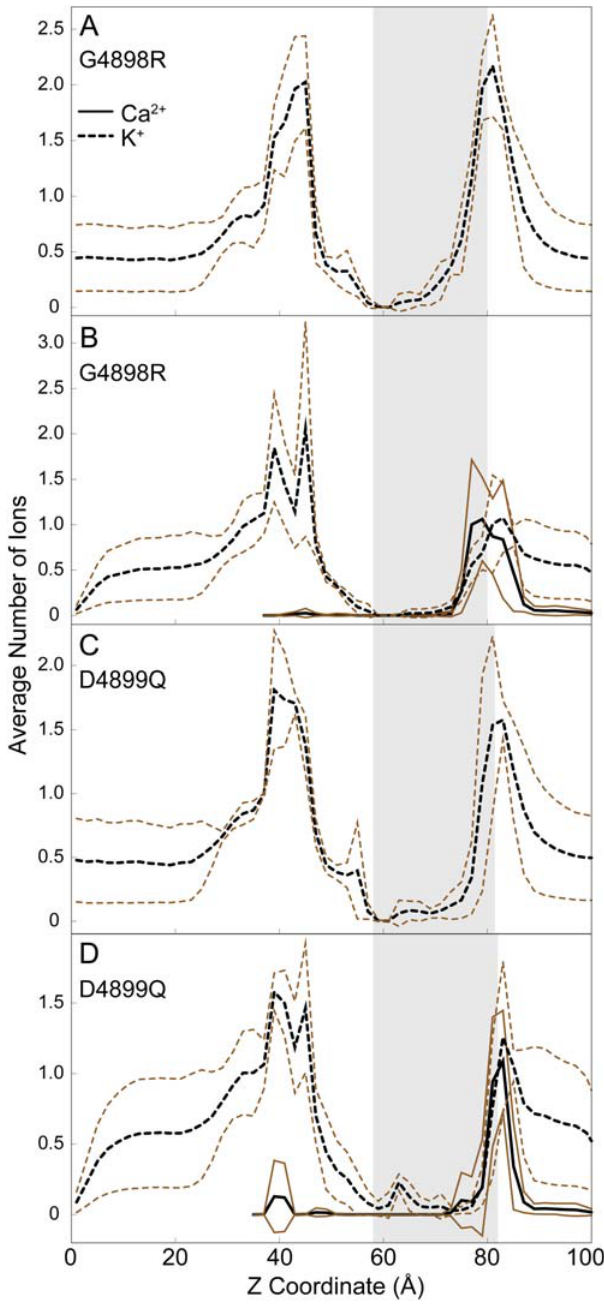
Figure 5. Histogram of ion occupancies along the axis of the mutant channels. (A) RyR1-G4898R in 250 mM KCl. (B) RyR1-G4898R in 250 mM KCl and 70 mM CaCl 2 . (C) RyR1-D4899Q in 250 mM KCl. (D) RyR1-D4899Q in 250 mM KCl and 70 mM CaCl 2 . The shaded region in the plots corresponds to the selectivity filter, determined the same way as in Figure 4. The average occupancy from 4 simulations is plotted in black, while lines corresponding to 6 1 SD are plotted in brown.